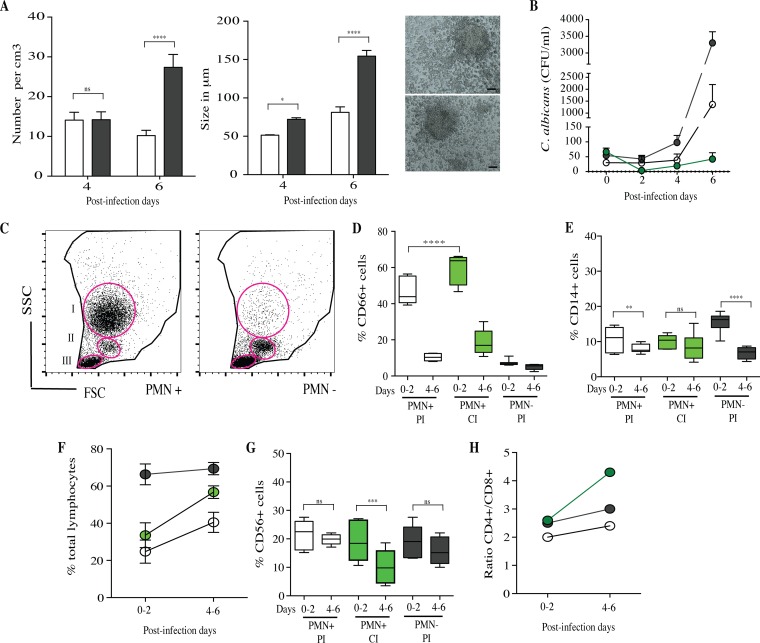
Characterization of PMN-depleted granuloma-like structures. (A) Number and size of granuloma-like structures on days 4 and 6 after infection by C. albicans species. Black bars, PMN-depleted conditions; white bars, nondepleted control conditions. Right images depict representative immune infiltrates observed under light microscopy 6 days after challenge under PMN-depleted conditions. (B) Dynamics of C. albicans CFU per milliliter over time. Shown are means ± SEM of the fungal burdens of C. albicans clinical isolates in PMN-depleted granuloma-like structures showing a PI status (gray circles), in PMN+ granuloma-like structures showing a PI status (white circles), and in PMN+ granuloma-like structures showing a CI status (green circles). (C) Representative flow cytometry analysis showing SSC-versus-FSC plot of granulocyte (I), monocyte (II), and lymphocyte (III) selection under PMN-depleted (PMN−) and nondepleted control (PMN+) conditions. CD66+ cells were gated from region I; CD14+ monocytes were gated from region II. CD3− CD56+, CD3+ CD4+, and CD3+ CD8+ cells were gated from region III. (D and E) The proportions of CD66+ and CD14+ cells within granuloma-like structures are expressed as percentages of the total living cell compartment. Box plots depict median, minimum, and maximum percentages of cells in PMN+ PI, PMN+ CI, and PMN− PI. (F) Total lymphocyte proportions according to PMN+ PI (white circles), PMN+ CI (green circles), and PMN− PI (gray circles) statuses. (G) Proportions of CD56+ cells within granuloma-like structures over time in PMN+ PI, PMN+ CI, and PMN− PI outcomes. (H) Dynamics of CD4+/CD8+ ratio over time. *, P < 0.05; **, P < 0.001; ***, P < 0.0001; ****, P < 0.00001 (by one-way ANOVA with Tukey's multiple-comparison test) (n = 40).